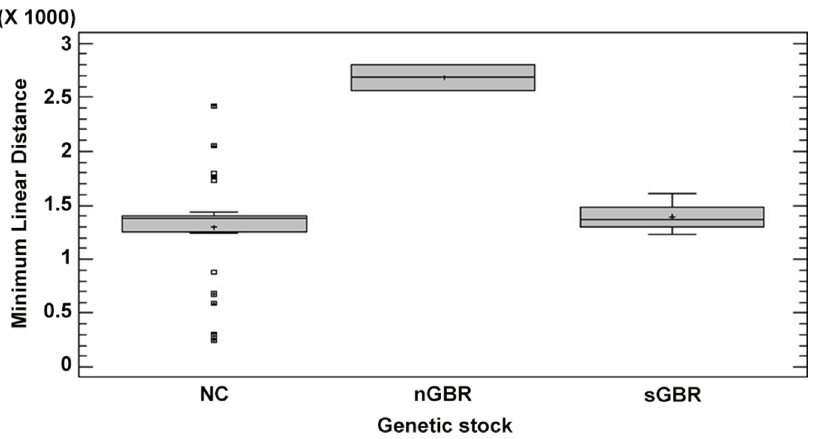
Figure 2. Mean linear minimum distance (km) ( 6 SE) from initial tagging locations in the Coral Sea. nGBR (n=2), sGBR (n=39) and NC (n=45).